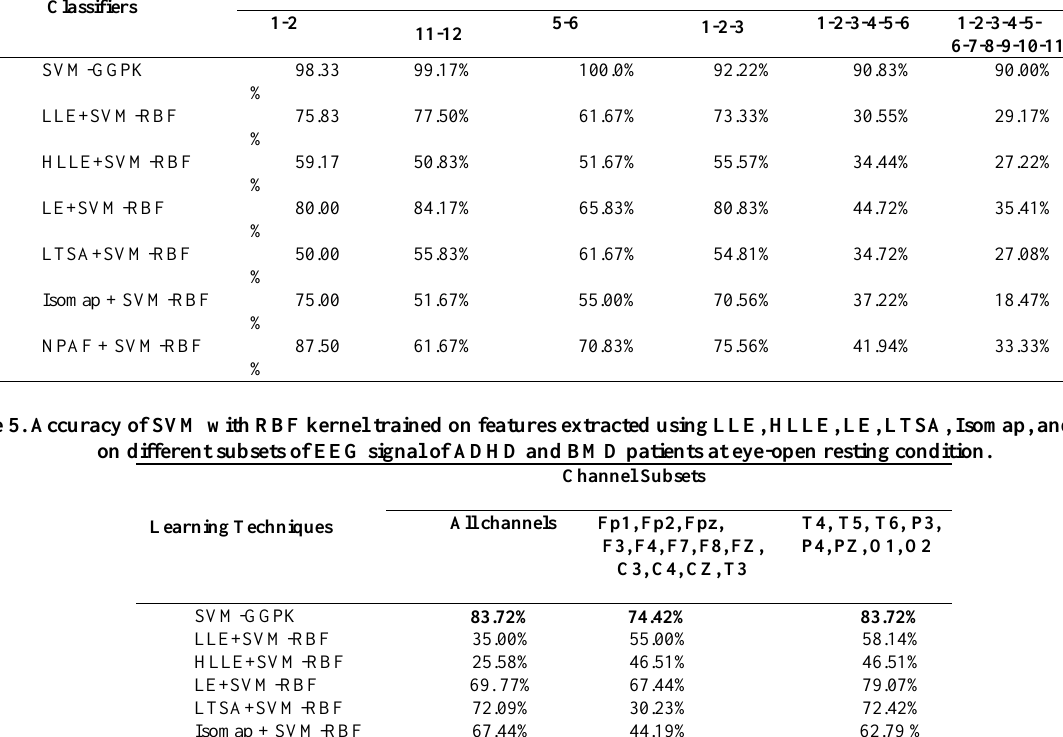
Table 4. Accuracy of SVM with RBF kernel trained on features extracted using LLE, HLLE, LE, LTSA, Isomap, and NPAF from different textures from Brodatz dataset. Texture No.